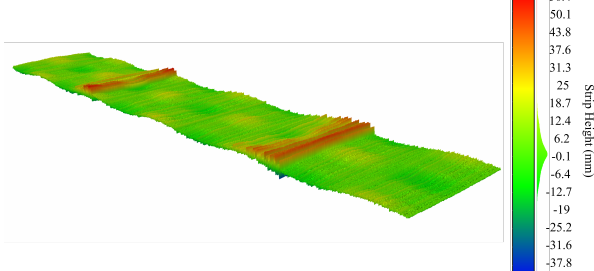
Figure 8. The synthetic surface after adding the effect of vibrations induced by different mechanical sources such as the shearing station (noise sources added).